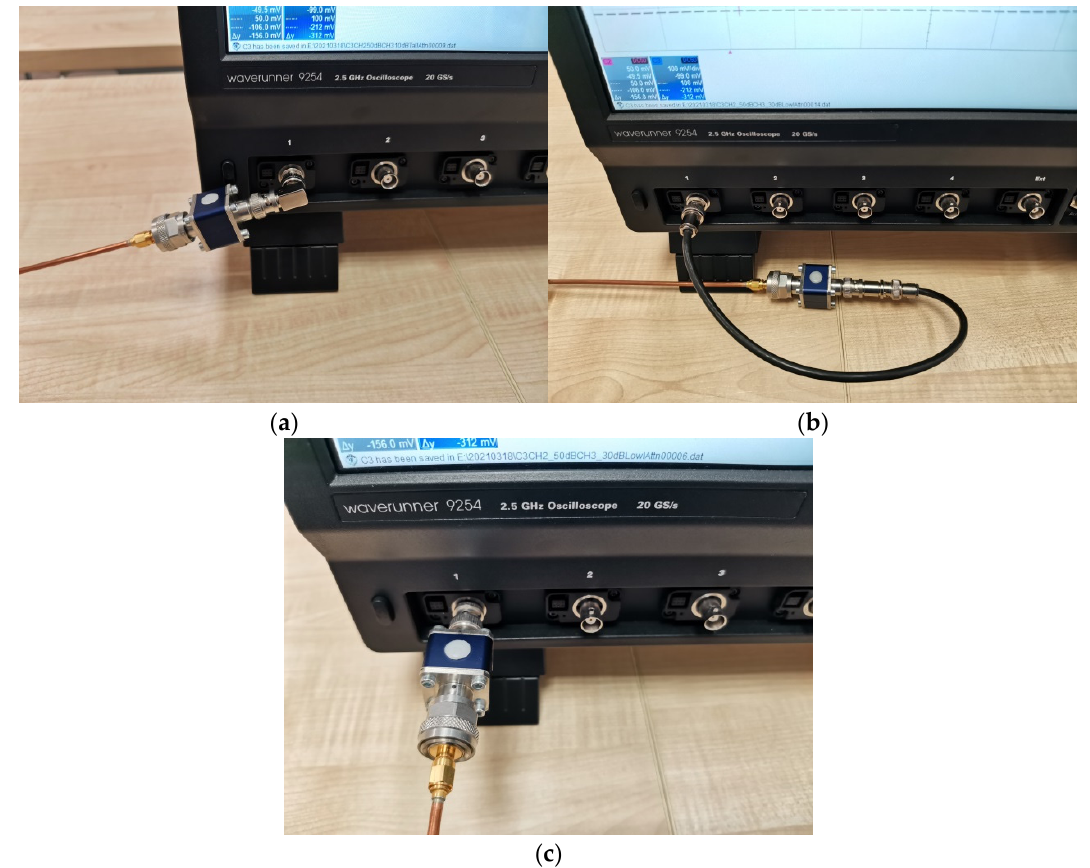
Figure 1. Probe manufacturer recommendations for the passive integrator connection: ( a , b ) not recommended, ( c ) recommended connection.